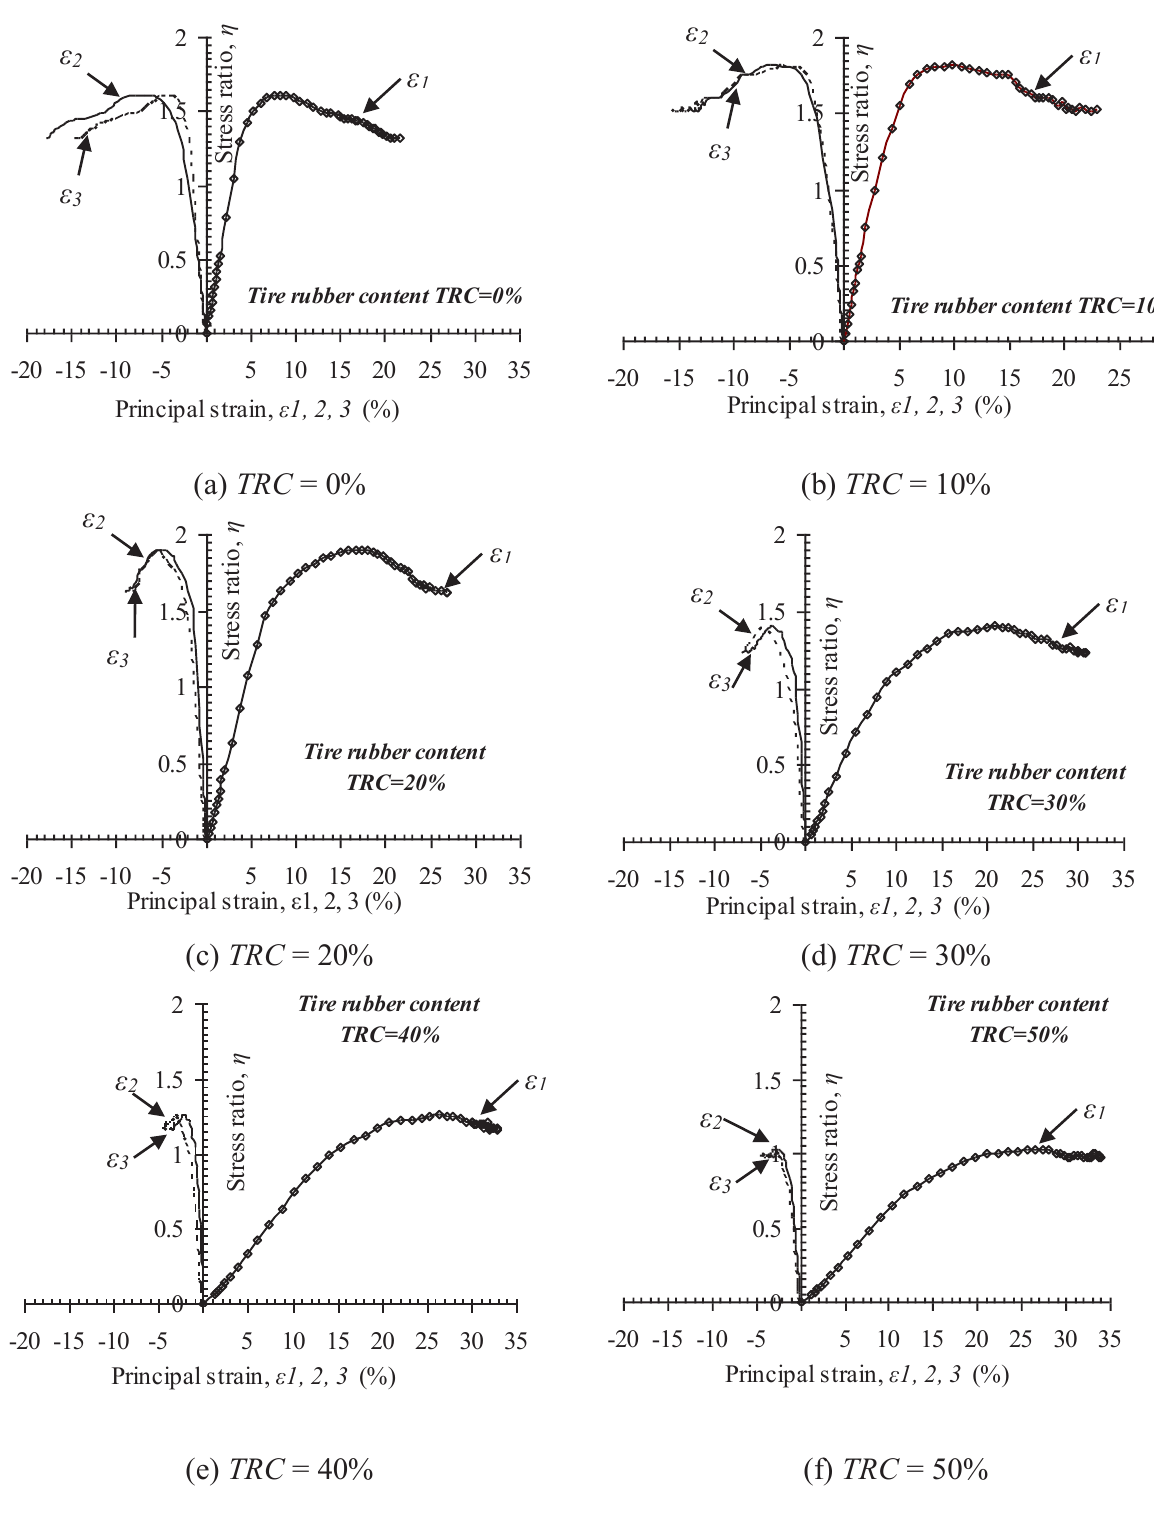
Fig. 7. Relationships between principal strains and stress ratio for sand mixed with different contents of tire rubber